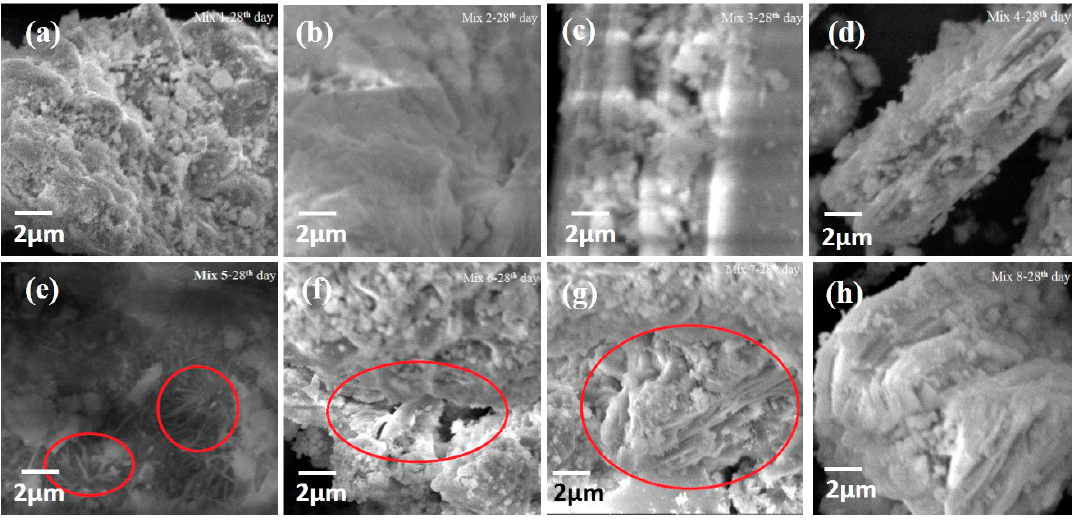
Figure 8. ( a – h ) SEM images represent the morphologies of Mixes 1 to 8 of hydration after the 28th